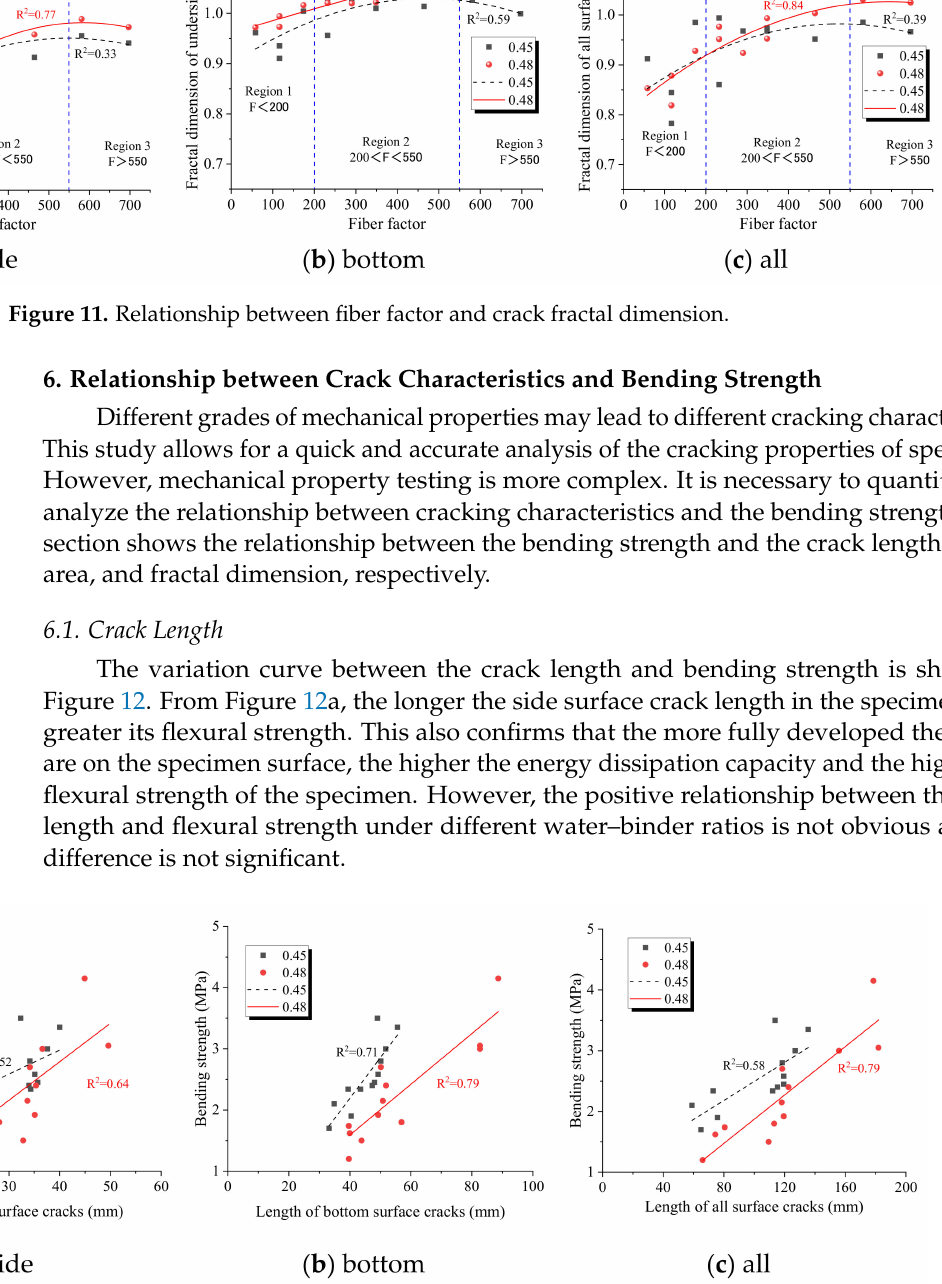
Figure 12. Relationship between bending strength and crack